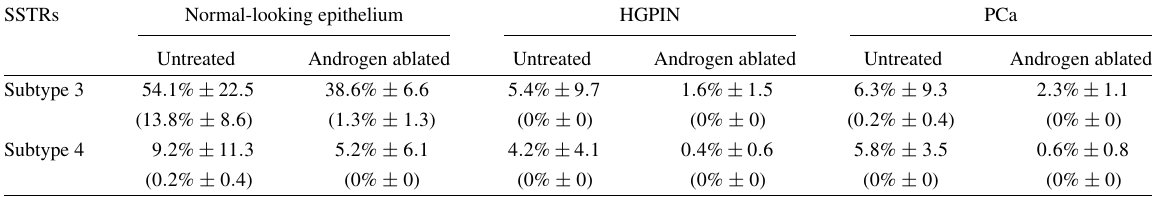
Percentages (mean ± standard deviation) of secretory cells with positive cell membrane staining SSTRs